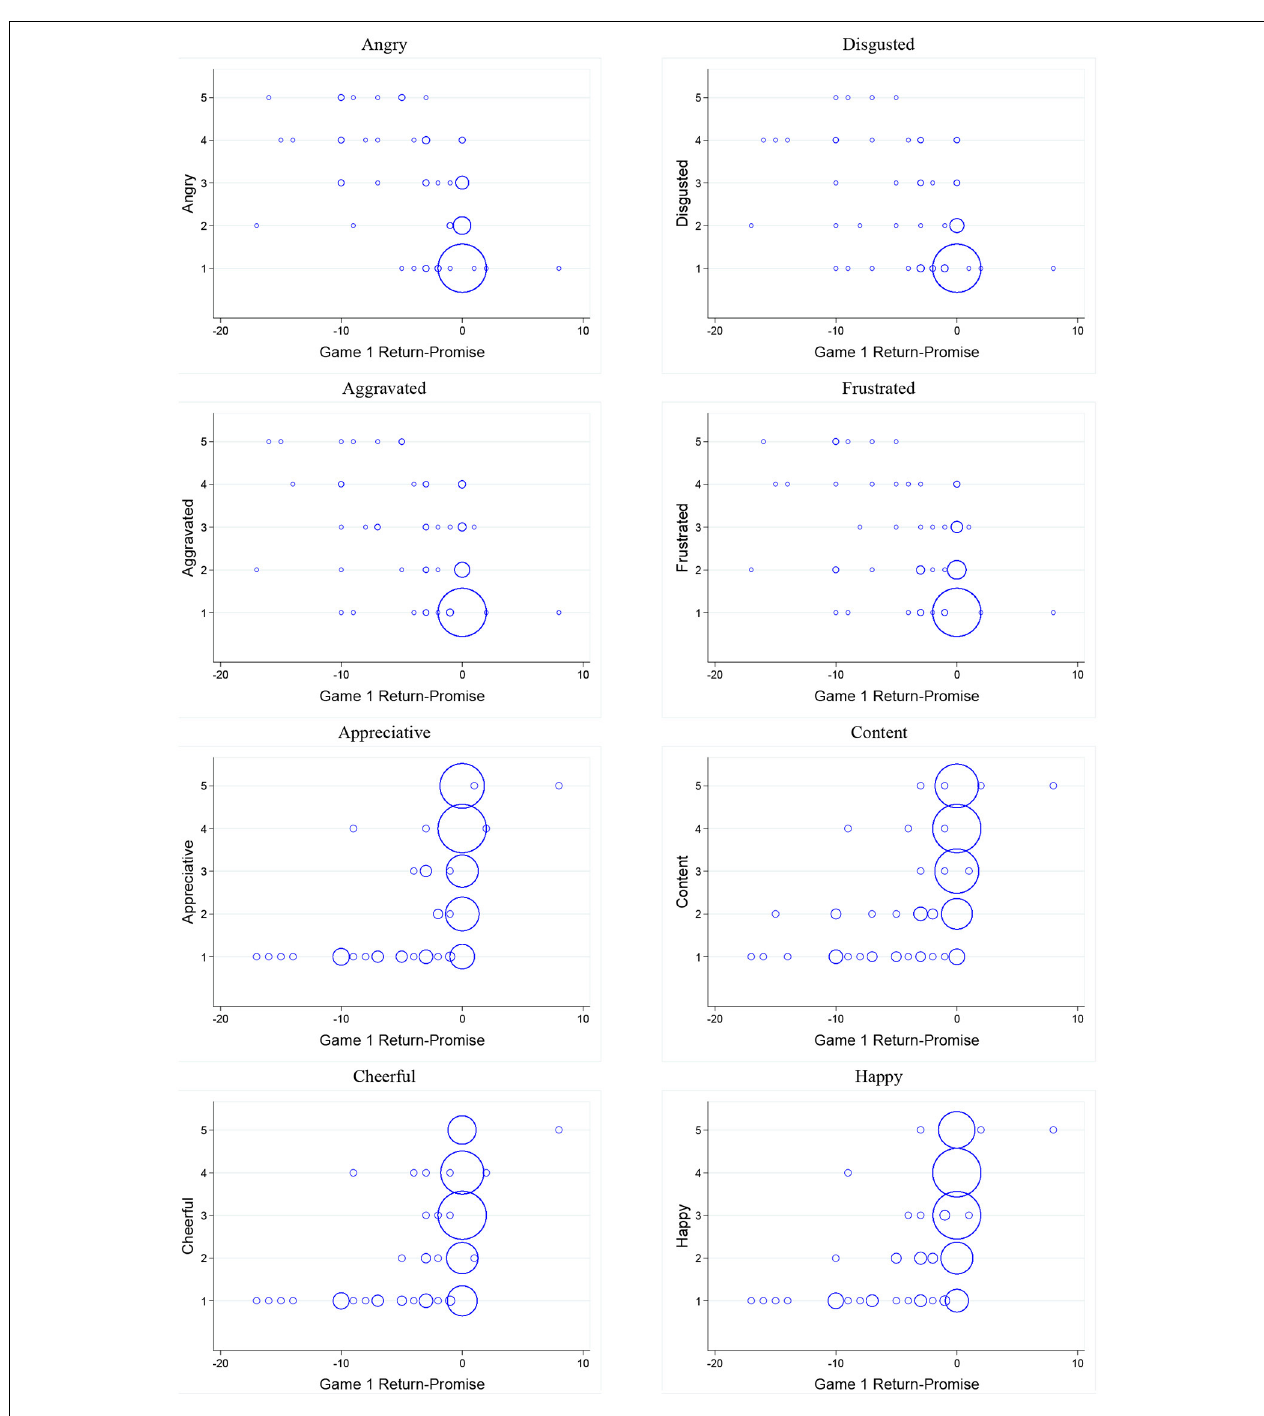
FIGURE 4 | Bubble plots of investors’ emotions and Signal value